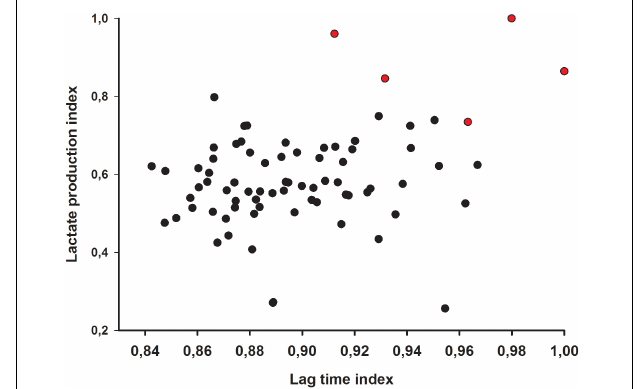
FIGURE 2 | Lag time and lactic acid index of 76 lactic acid bacteria isolates. Red dots indicate selected candidate isolates.